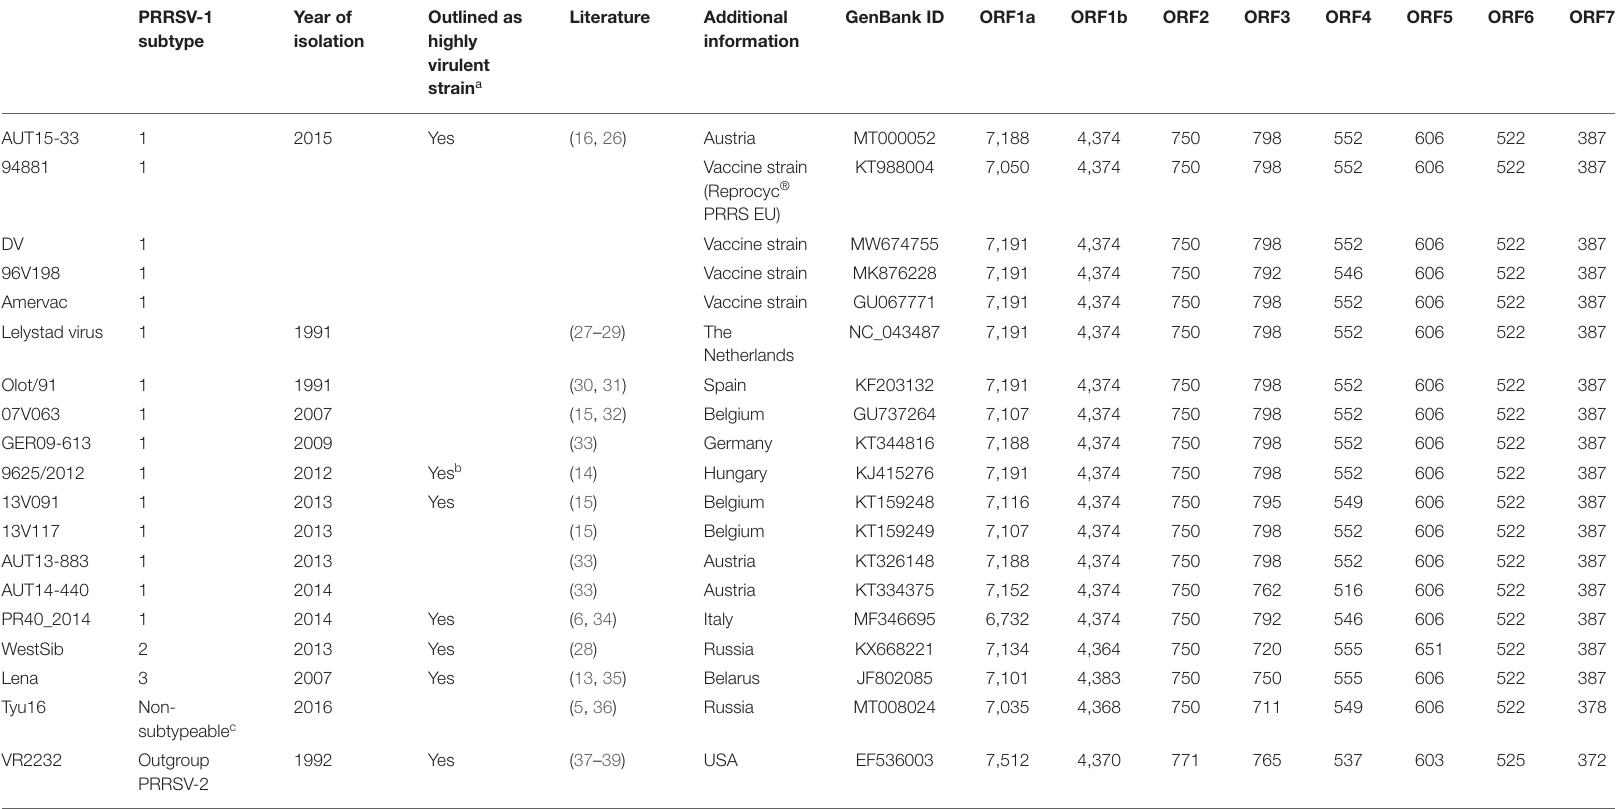
TABLE 1 | Overview of the nucleotide lengths for individual open reading frames of selected porcine reproductive and respiratory syndrome virus